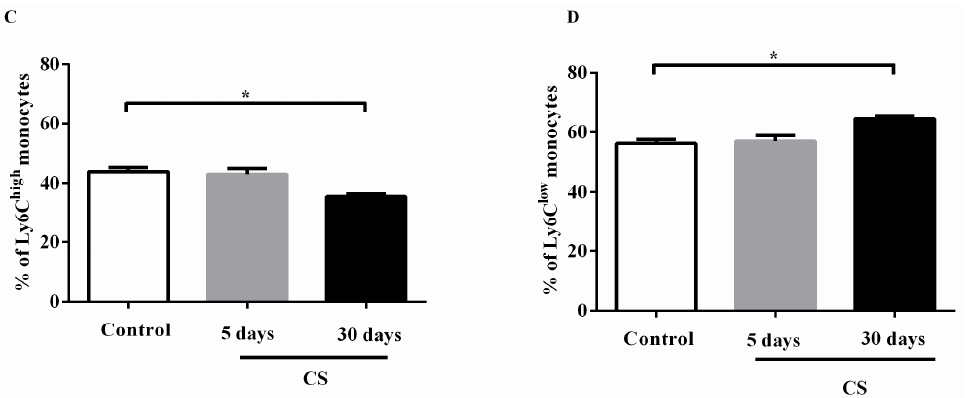
Figure 6. Effects of CS on the % of Ly6C high ( A and C ) and Ly6C low ( B and D ) monocytes in blood and bone marrow of mice. The percentage of Ly6C high (classical) monocytes and Ly6C low (non-classical) monocytes was determined by flow cytometry. All statistical analyses were performed with a one-way ANOVA, followed by a Tukey’s post hoc test. The data represent the means ± SEM of 7–10 mice per group. * p < 0.05 compared to control; * p < 0.05 compared to 5 days group.